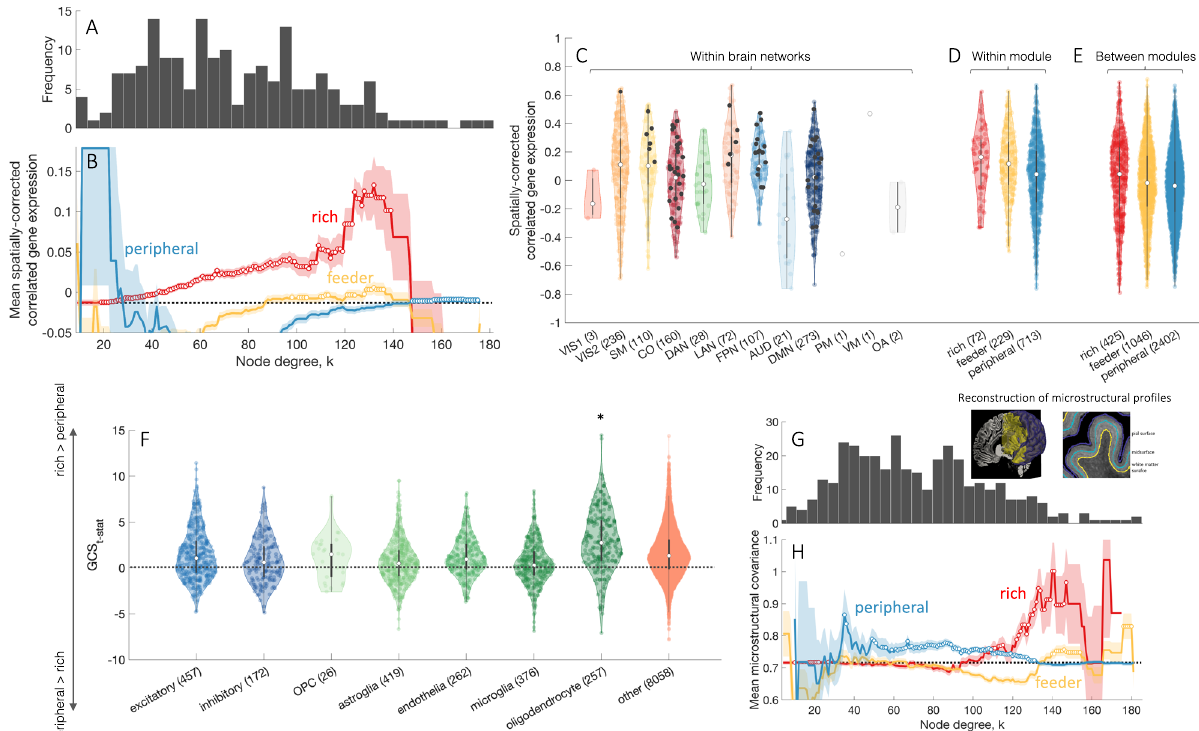
Fig. 3 Transcriptional coupling is elevated for connected brain network hubs. A The degree distribution of the representative group-level connectome of brain regions in the left cortical hemisphere. Degree is computed from whole-brain connectivity. B Mean correlated gene expression (CGE) for rich (hub – hub), feeder (hub – nonhub), peripheral (nonhub – nonhub) connections as a function of the degree threshold, k , used to de fi ne hubs. The mean CGE across all network links is shown as a dotted black line. The shaded area corresponds to the standard error of the mean, circles indicate a statistically signi fi cant increase in CGE in a given link type compared to the rest of the network (one-sided Welch ’ s t -test, uncorrected p < 0.05). CGE estimates are corrected for distance effects, as detailed in the Methods section. C CGE within functionally de fi ned networks as in Fig. 2E. Black dots represent CGE values for rich links ( k > 105). CGE values within ( D ) and between ( E ) functional modules in the left hemisphere across different link types (rich, feeder, and peripheral). Inter-module rich links show signi fi cantly higher CGE compared to both feeder (one-sided Welch ’ s t -test, p = 0.03) and peripheral links ( p = 1.5 × 10 − 4 ). Within functional modules, rich links show higher CGE compared to peripheral ( p = 1.2 × 10 − 4 ) but not to feeder links ( p = 0.5). F Gene contribution score t -statistic values (GCS t-stat ) for cell-speci fi c gene groups quantifying the contribution of individual genes towards increased CGE for rich compared to peripheral links. Neuronal gene groups (excitatory — excitatory neurons; inhibitory — inhibitory neurons) are colored blue; glial gene groups (OPC — oligodendrocyte progenitor cells, astroglia, endothelia — endothelial cells, microglia, oligodendrocytes) colored green; values for all other genes presented in light orange. Oligodendrocyte-related genes show a statistically signi fi cant increase in GCC compared to all other genes (one-sided Welch ’ s t -test, p = 2 × 10 − 11 ). For distributions presented in C – F white dots represent median values for each distribution. The interquartile range is represented with a dark gray box, whiskers are represented with a light gray line. G The degree distribution of the representative group-level cortical connectome. H Mean microstructural pro fi le covariance (MPC) for rich (hub – hub), feeder (hub – nonhub), peripheral (nonhub – nonhub) connections as a function of degree threshold, k used to de fi ne hubs. The MPC across all network links is shown as a dotted black line. Shaded area corresponds to the standard error of the mean, circles indicate a statistically signi fi cant increase in MPC in a given link type compared to the rest of the network (one-sided Welch ’ s t -test, uncorrected p < 0.05). Inset near the degree distribution shows examples of the intermediate surfaces used to assay microstructure across the cortical depth (reproduced with permission from 49 ). Source data are provided as a Source Data fi